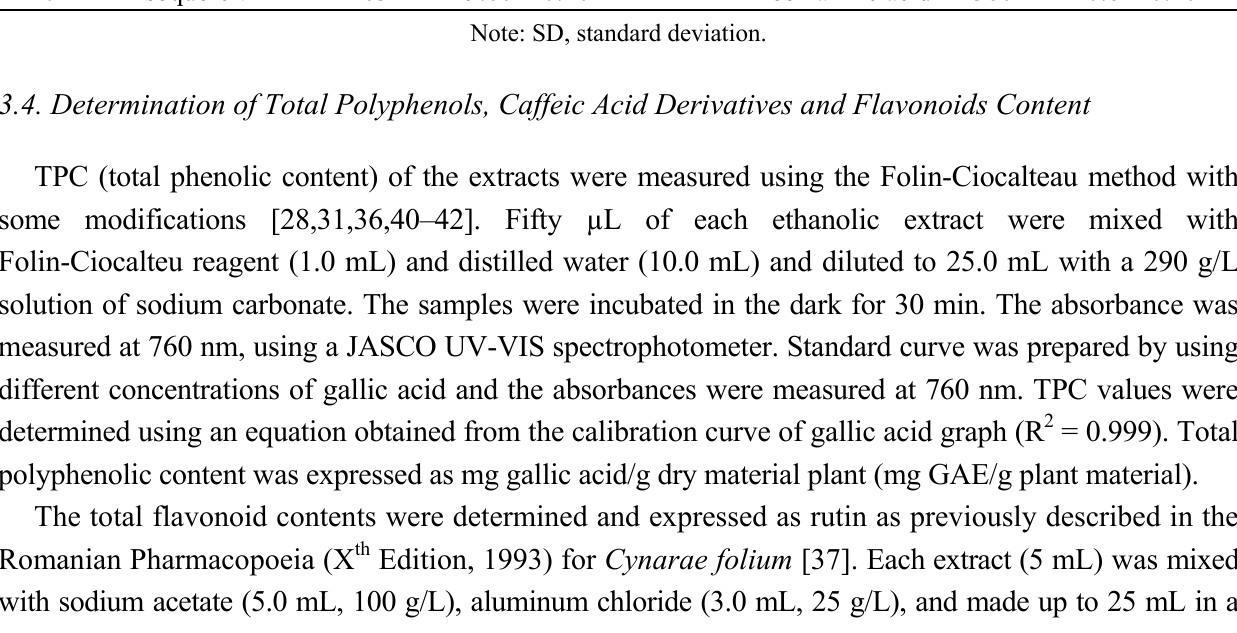
Table 5. Retention times (R